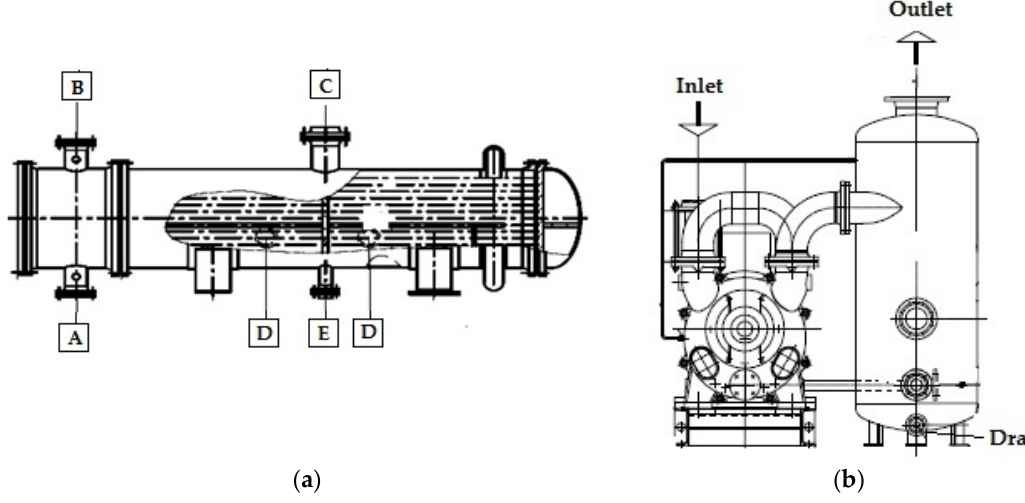
Figure 15. General views of the proposed condenser ( a ) and LRVP ( b ).